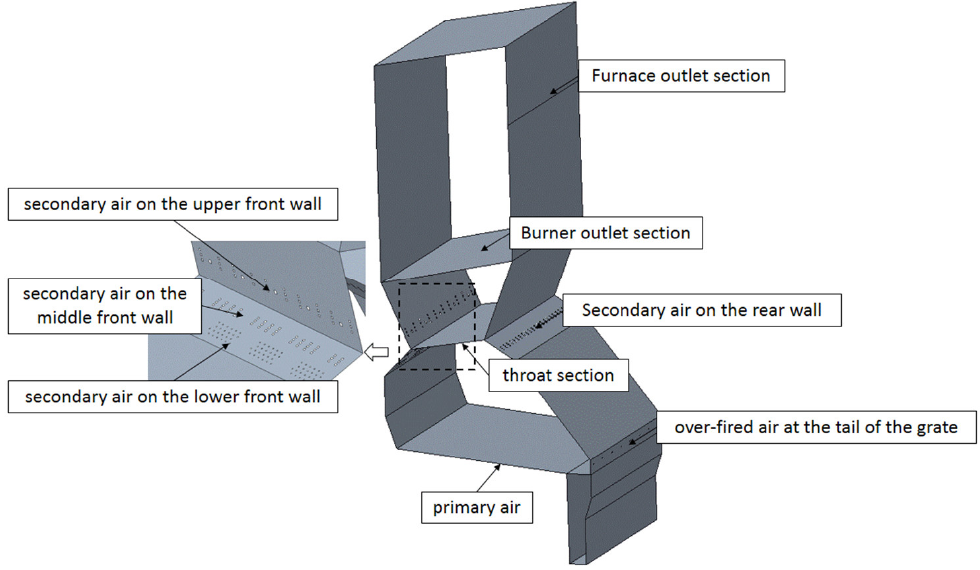
Figure 1. The sketch of the grate boiler with a steam generation rate of 130 t/h.